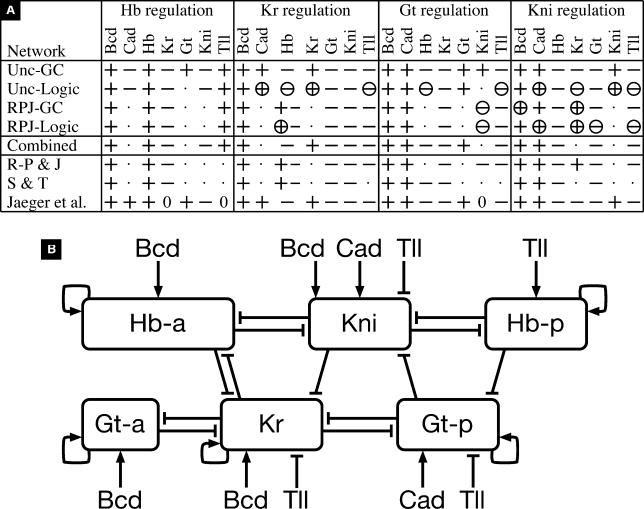
Regulatory Relationships in Our Models and Previously Published Models(A) Qualitative regulatory relationships in our four models after optimization (Unc-Gc, Unc-Logic, RPJ-GC, and RPJ-Logic), a Combined model (see text for details), and the relationships posed by Rivera-Pomar and Jäckle (R-P & J) [3], Sanchez and Thieffry (S & T) [4], and Jaeger et al. [6,7]. “+” represents activation, “−” represents repression, “+−” represents activation at low levels of the regulator and repression at high levels, “·” represents no regulatory relationship. For Jaeger et al., “0” represents a regulatory relationship that was eliminated by optimization. For our models, we use “⊕” and “⊝” to denote activating and repressing relationships, respectively, that were eliminated by optimization. For the gene circuit models, a regulatory relationship was considered eliminated if the corresponding weight was 0.0001 or less in magnitude. For the logical models, an activation or repression term was considered to be eliminated if removing it resulted in no change in simulated expression.(B) Diagram of the Combined network model. Boxes represent trunk gap gene domains, with endings “-a” or “-p” denoting the anterior and posterior domains, respectively, for hb and gt. Arrows (→) indicate activation while T-connectors () represent repression.